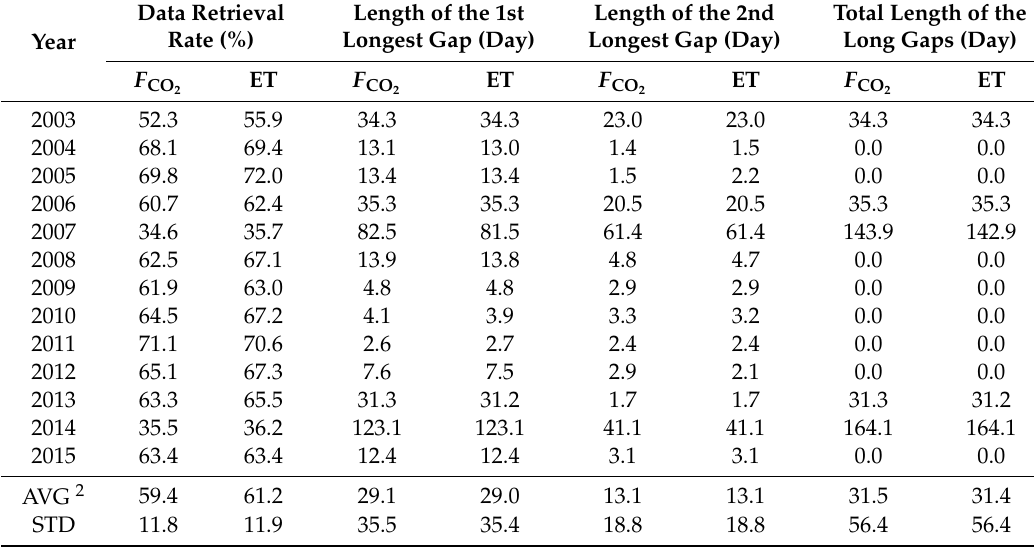
Table 1. Annual data retrieval rates, lengths of the first and second longest gaps, and total lengths of the long gaps 1 for CO 2 flux ( F CO ) and evapotranspiration (ET) from 2003 to 2015 for the study site. 2 AVG denotes average; STD denotes standard